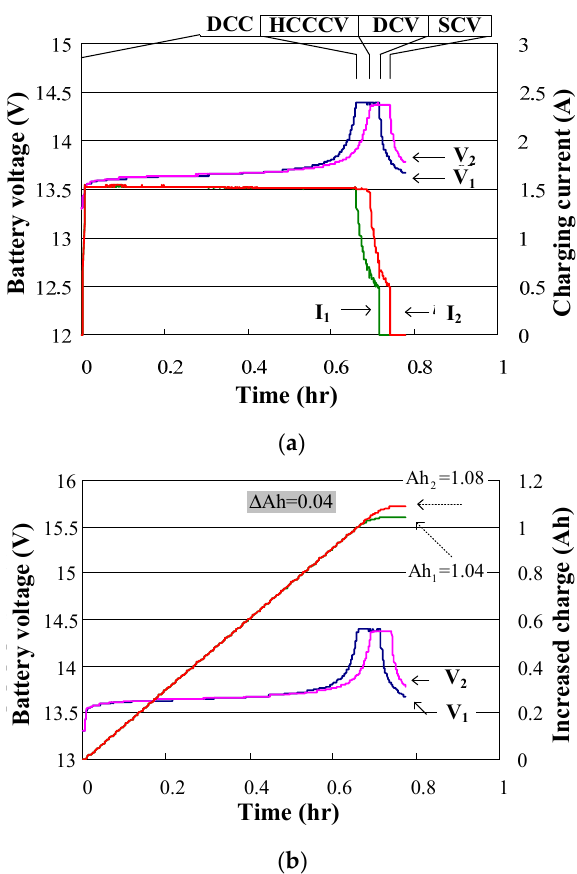
Figure 16. Measured data of charging two battery with small SoC difference. ( a ) the measured waveforms of voltages and currents; ( b ) the measured data of